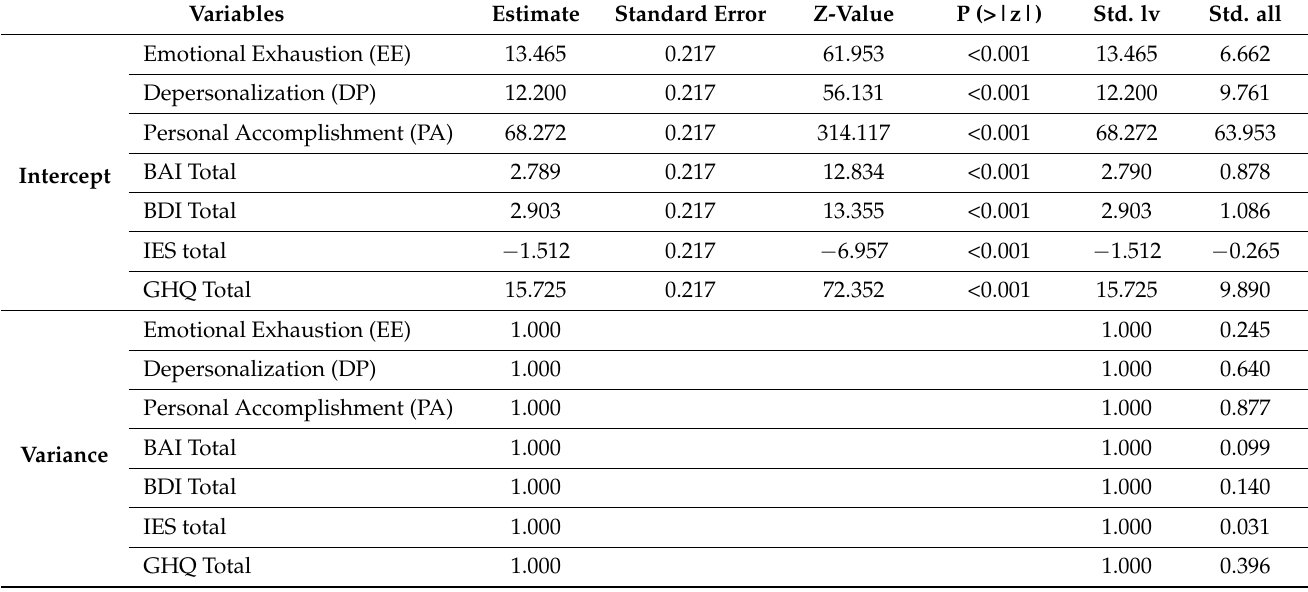
Table 6. Intercept and variance of Emotional Exhaustion (EE), Depersonalization (DP), Personal Accomplishment (PA), Beck Depression Inventory (BDI), Beck Anxiety Inventory (BAI), Impact of Event Scale (IES) and General Health Question- naire